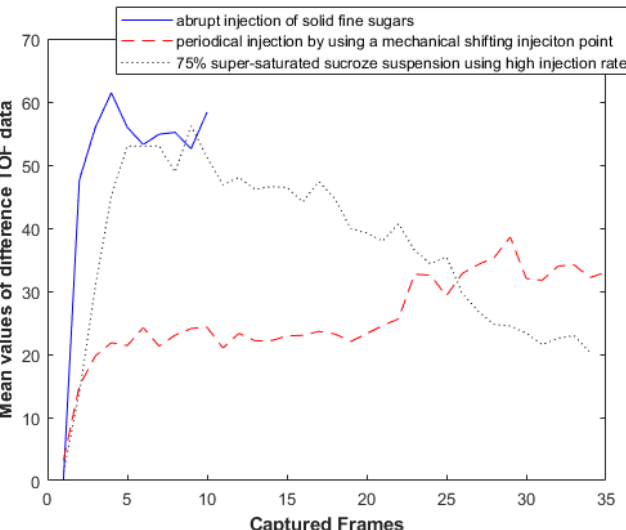
Figure 7. Plot of all frames’ mean value of difference data. The ascending trend of the graph reveals the gradually increasing delay that was introduced to the raw TOF data. The first experiment with the pouring of solid particles of fine sugars lasted for a lot less than the others, according to its nature.